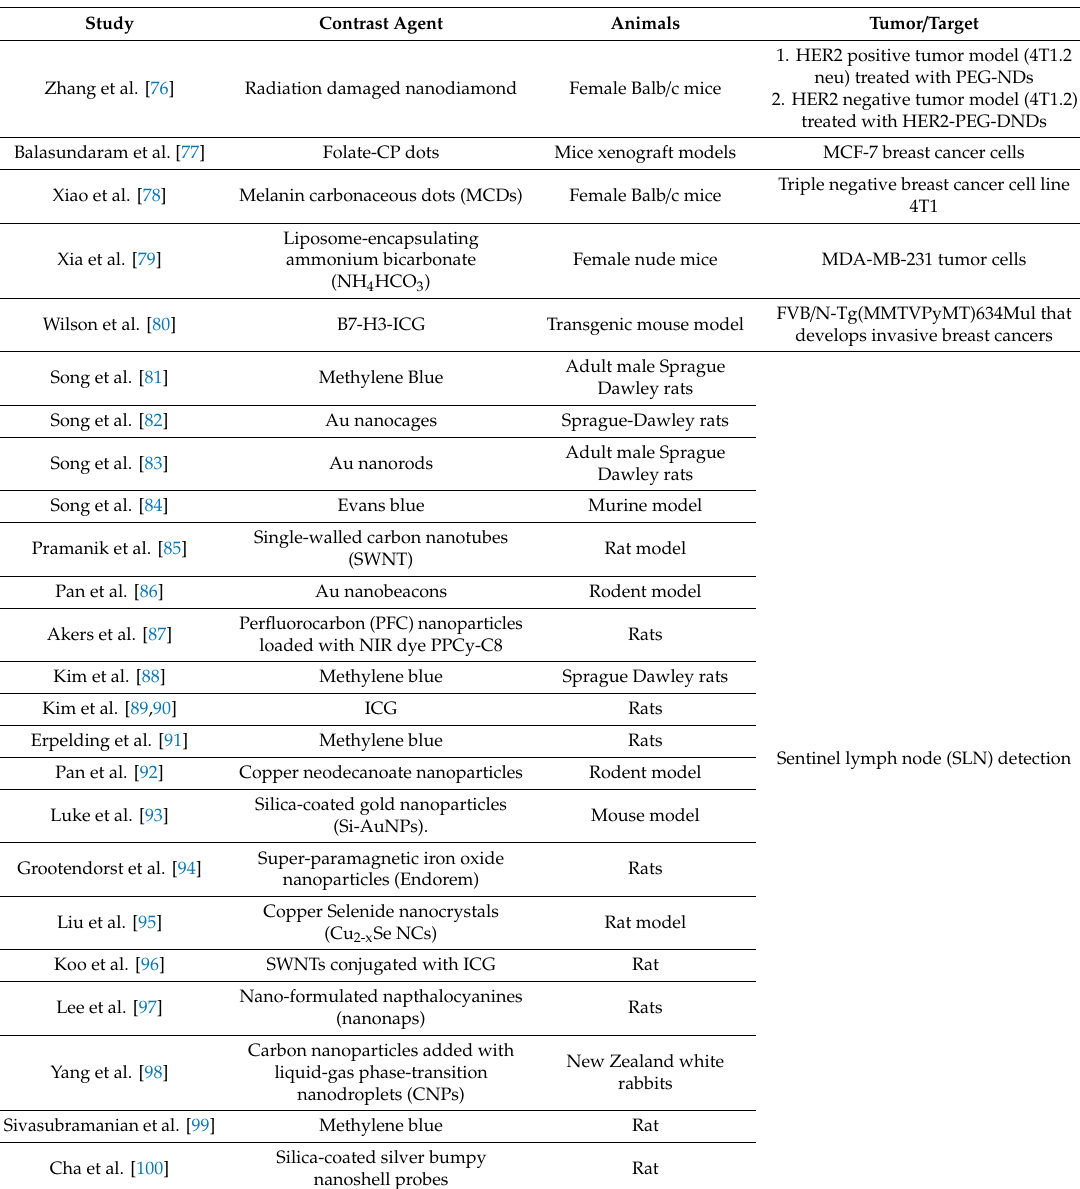
Table 4. Details of studies using exogenous contrast